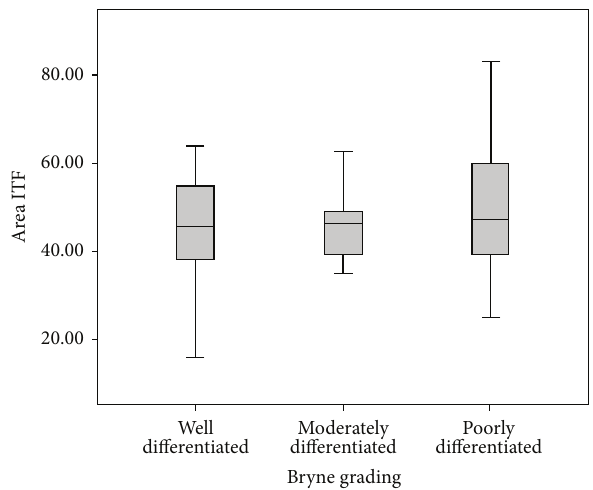
Figure 5: This graph depicts the relation of nuclear area at invasive front with Bryne et al. grading in oral squamous cell carcinoma patients (graph depicted “area tumour proper as Area TP”) ( 𝑛 = 32 ). The statistical significance was calculated using Chi-square test and